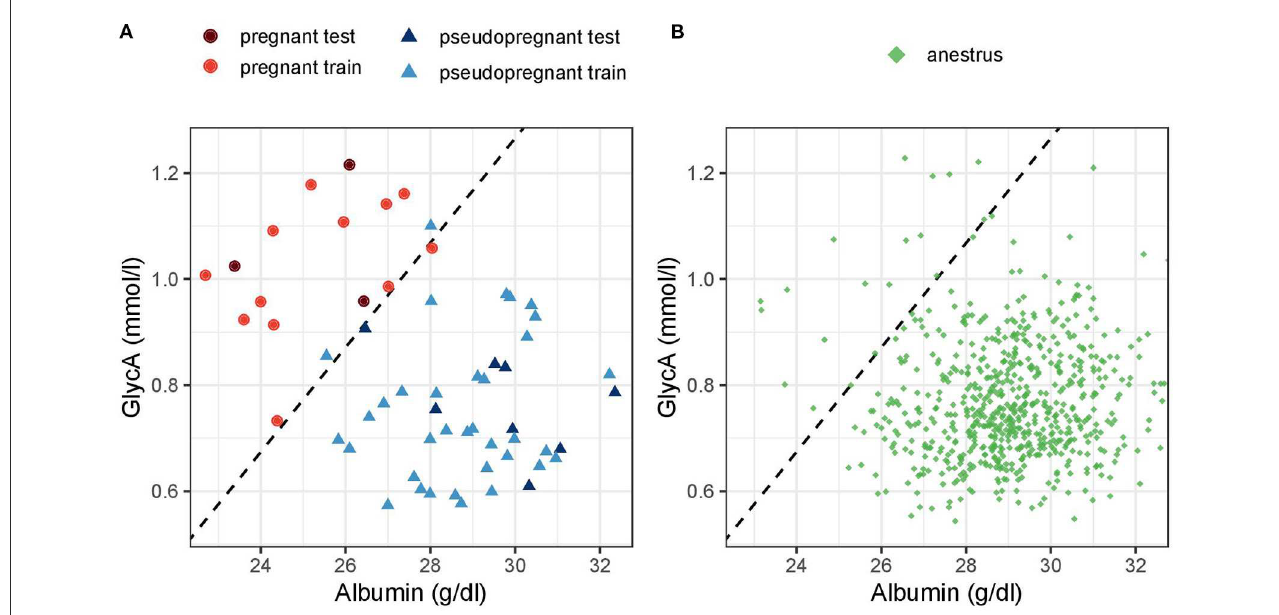
FIGURE6 Scatter plot of (A) pregnant and pseudopregnant dogs in the testing and training data and (B) dogs in anestrus based on albumin and glycoprotein acetyls (GlycA) concentration. The dashed line represents the decision threshold for a cutoff of 0.5 of the multivariate Firth logistic regression model. Dogs above the dashed line (the top left) would be classified as pregnant and dogs below it (down right) as